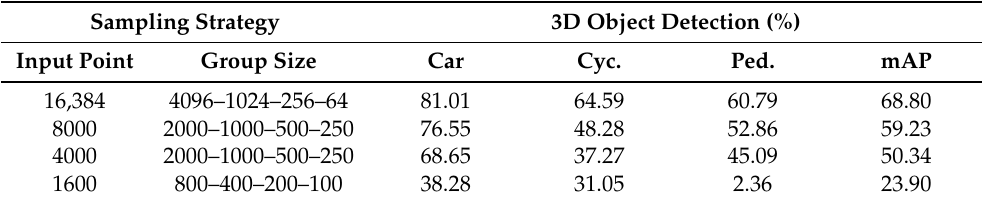
Table 2. Detection performance of PointRCNN on the validation set under different sampling strate-